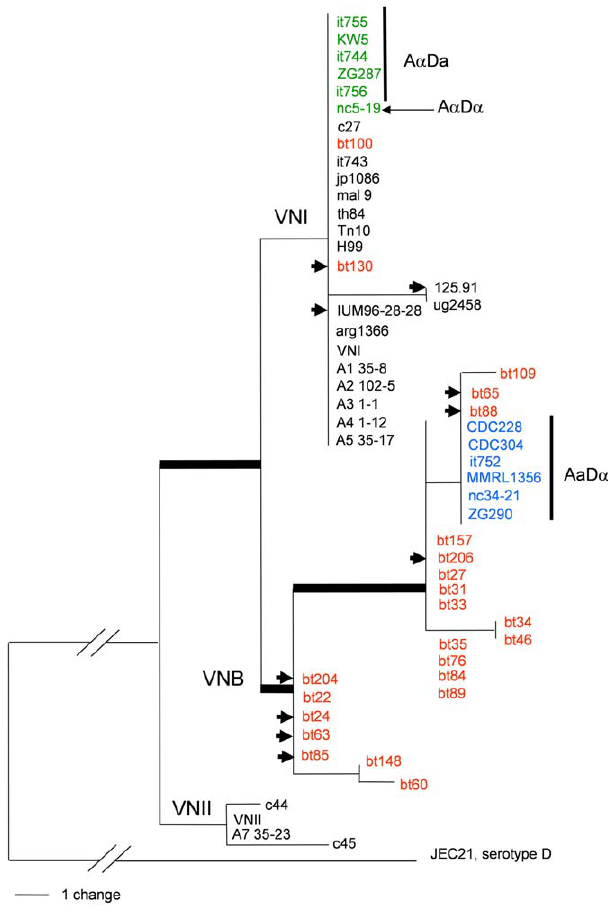
Figure 3. Bayesian Consensus Tree for 12 AD Hybrid Strains and 45 Representative Strains of Serotype A Based on the Combined Data for the Three Loci The tree is rooted with the sequences from the JEC21 strain of serotype D, and branch lengths leading to the outgroup are shortened to fit the figure. Thickened lines denote clades supported by Bayesian posterior probabilities (cid:2) 95%. VNI, VNII, and VNB refer to the subgroups (molecular types) identified within serotype A [22]. A a D a hybrid isolates are shown in blue, A a D a hybrid isolates are shown in green, and isolates from Botswana are shown in red. Strains of serotype A that possess MAT a allele are marked with